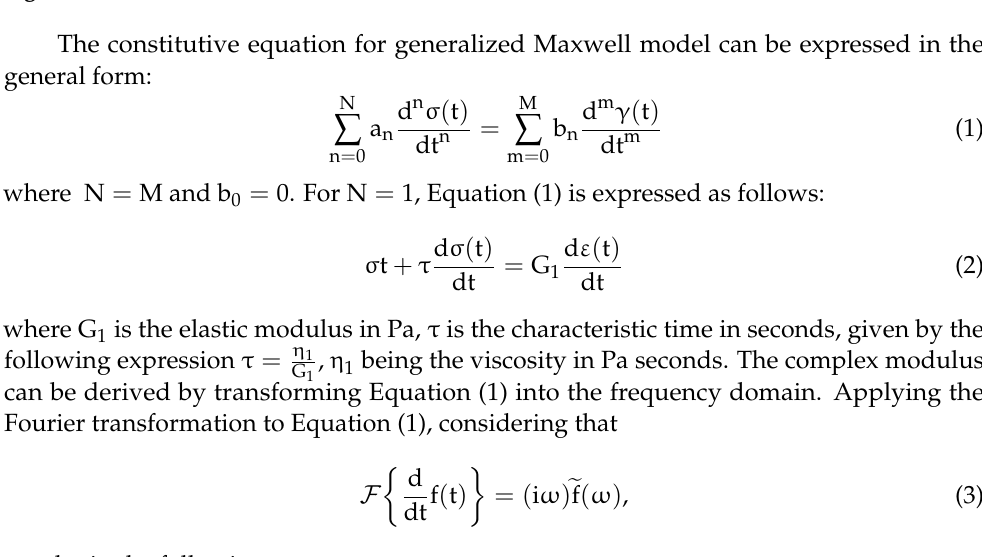
Figure 1. Generalized Maxwell model.